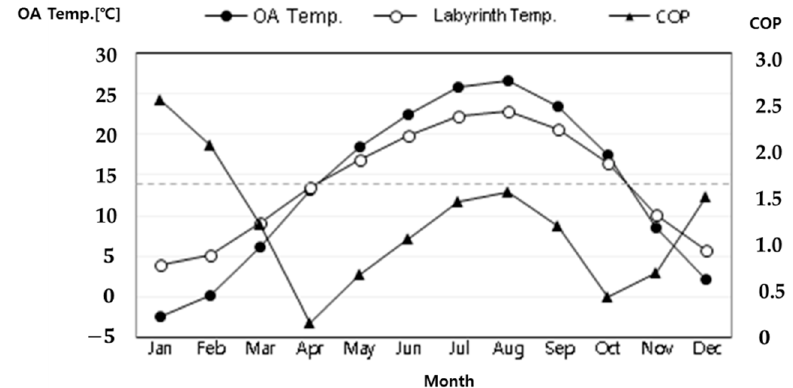
Figure 10. Monthly average outdoor air (OA) temperature, optimized thermal labyrinth temperature, and COP.